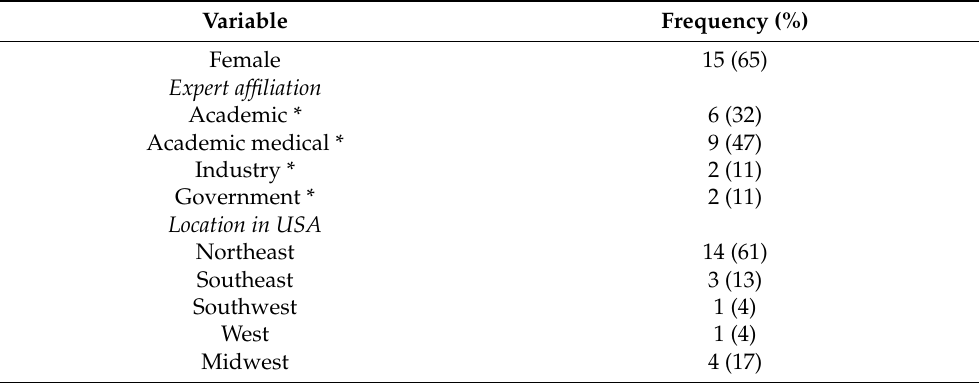
Table 2. Demographic characteristics of caregiving experts ( n = 23).